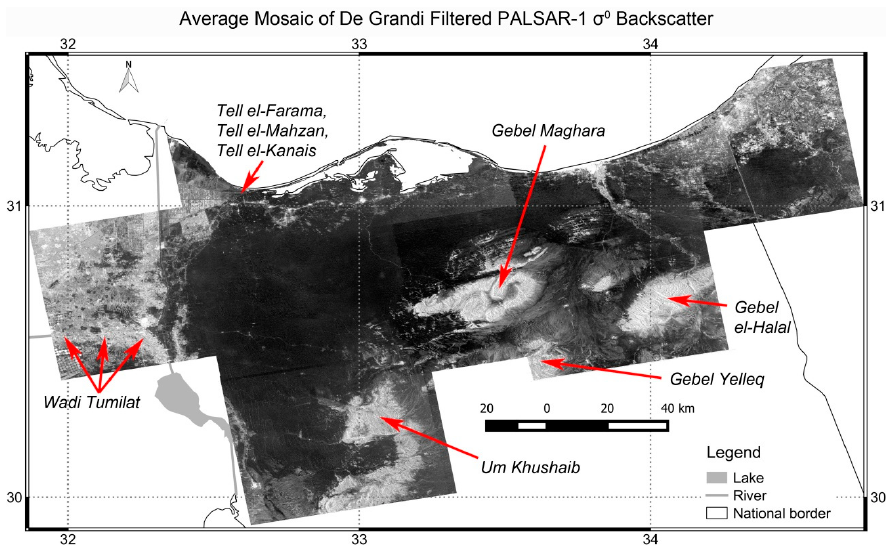
Figure 5. Final ALOS PALSAR-1 mosaic of North Sinai annotated with geographic features and showing the location of the Tells, where features of low relative backscatter were identified. PALSAR-1 data provided by